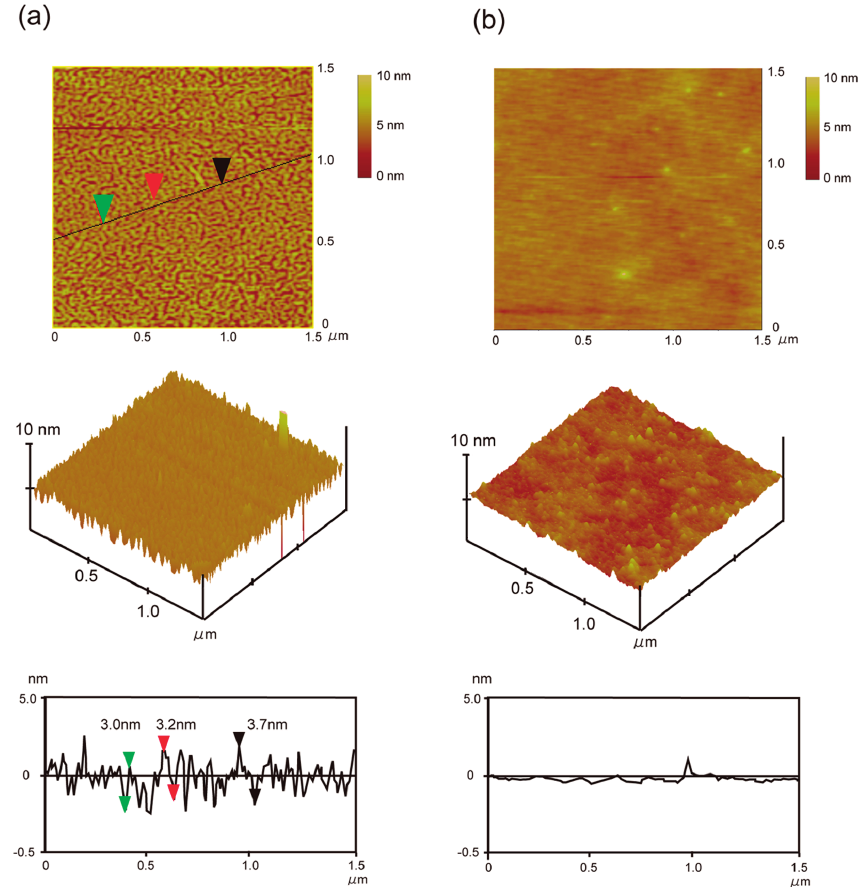
Figure 3. Tapping-mode (TM) AFM images of the ( a ) hydrophobic and ( b ) hydrophilic glass plates obtained after immersion into aqueous solution of RGDS-ELP at 37 °C, respectively. [RGDS-ELP] = 0.1 mg/mL, z -scale: 10 nm. Bottom figures show the detailed analysis of the heights of the